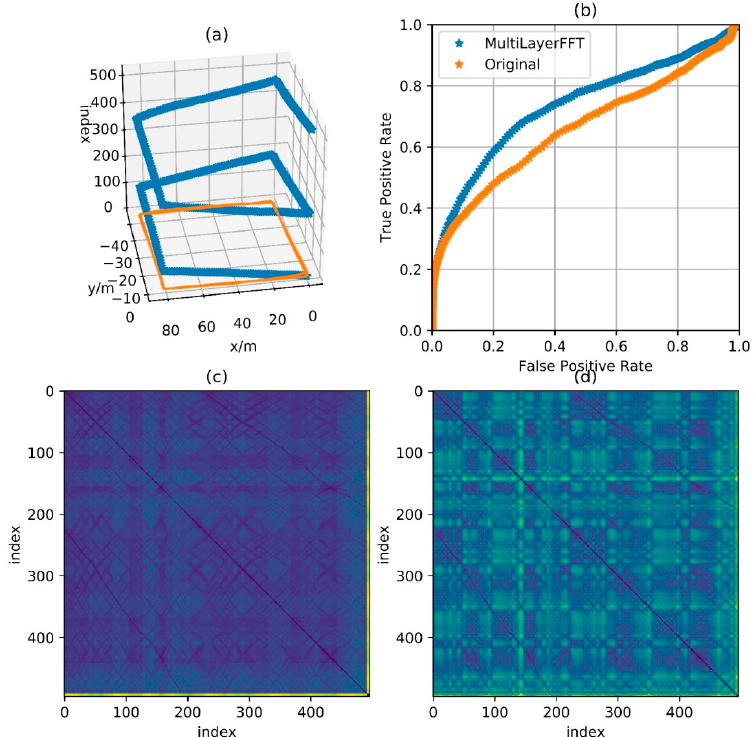
Figure 12. Comparison of performance between BDD and MFD in Path B. ( a ) Reference trajectory. ( b ) ROC of BDD and MFD. ( c ) Distance matrix of BDD. ( d ) Distance matrix of MFD.